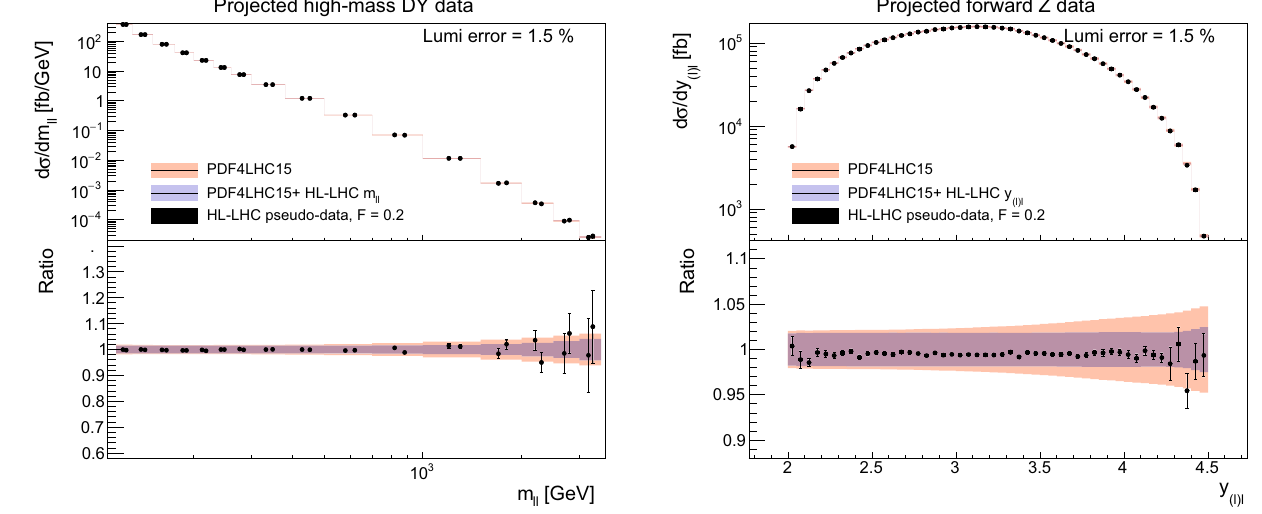
shown in the experimental errors. In the bottom panel, we show the same results normalised to the central value of the original theory cal- culation.Noteintherightplotthecomparisonareonlymadeforforward Z data though both W and Z data are included in the